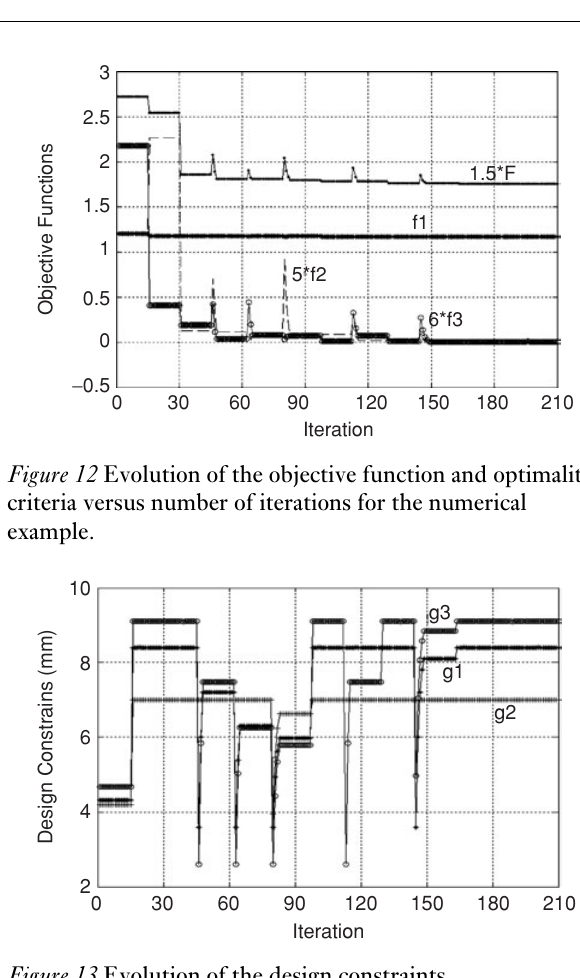
Figure 13 Evolution of the design